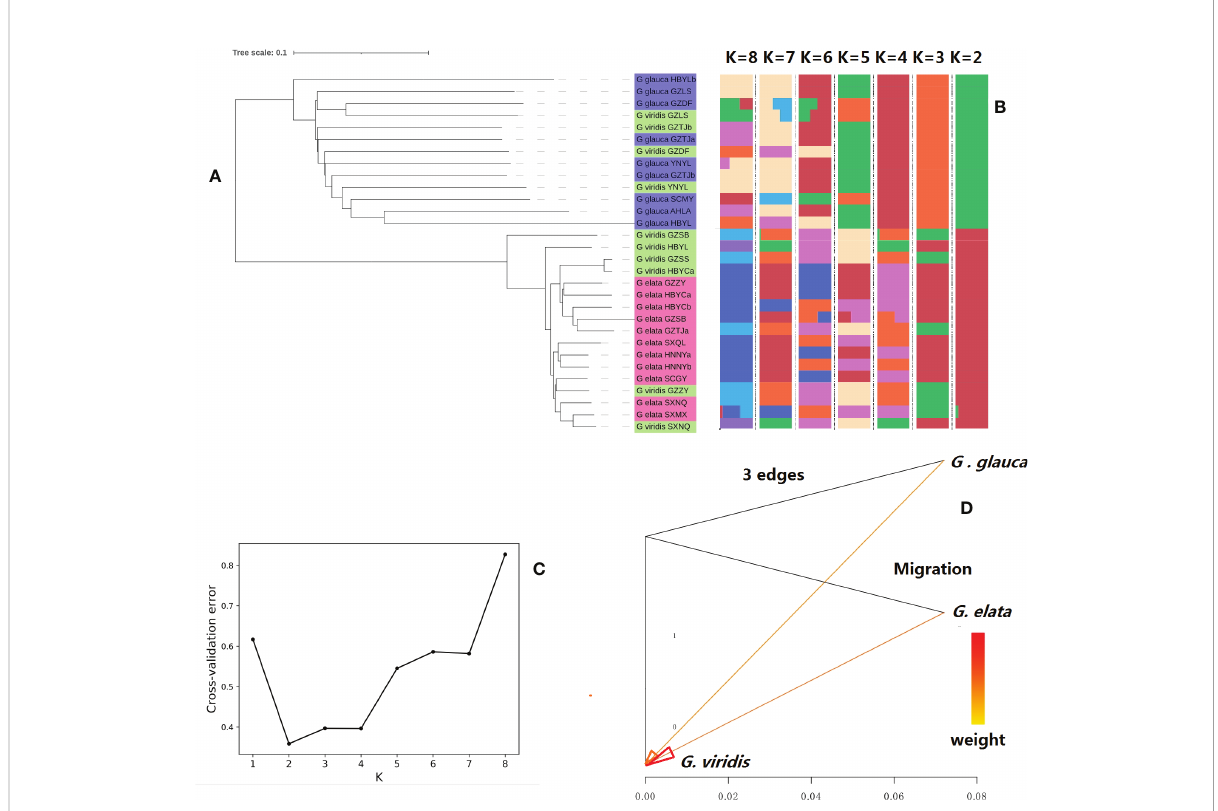
FIGURE 3 Population structure and gene fl ow analysis of 30 accessions of Gastrodia elata (GE) samples: (A) neighbor-joining phylogenetic tree; (B) admixture structure; (C) : the genetic population number (K) and its corresponding value of cross-validation error generated by admixture analysis (note: K = 2 denotes the lowest cross-validation error, suggesting that the samples should be clustered into two different genetic populations); (D) : gene fl ow among (G) elata.f.glauca , ( G ) elata.f.elata , and (G) elata.f.viridis populations. Note: Abscissa shows the value of gene fl ow and arrow indicates the direction of gene fl